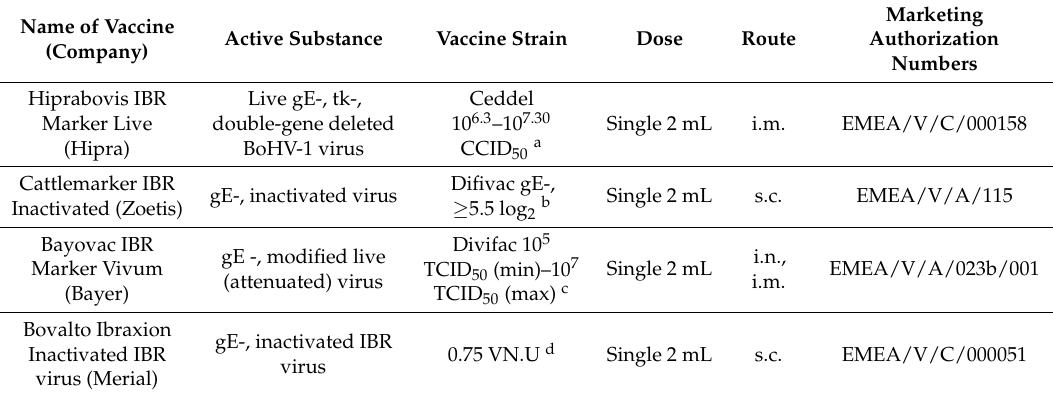
Table 1. Infectious bovine rhinotracheitis (IBR) marker vaccines available in European